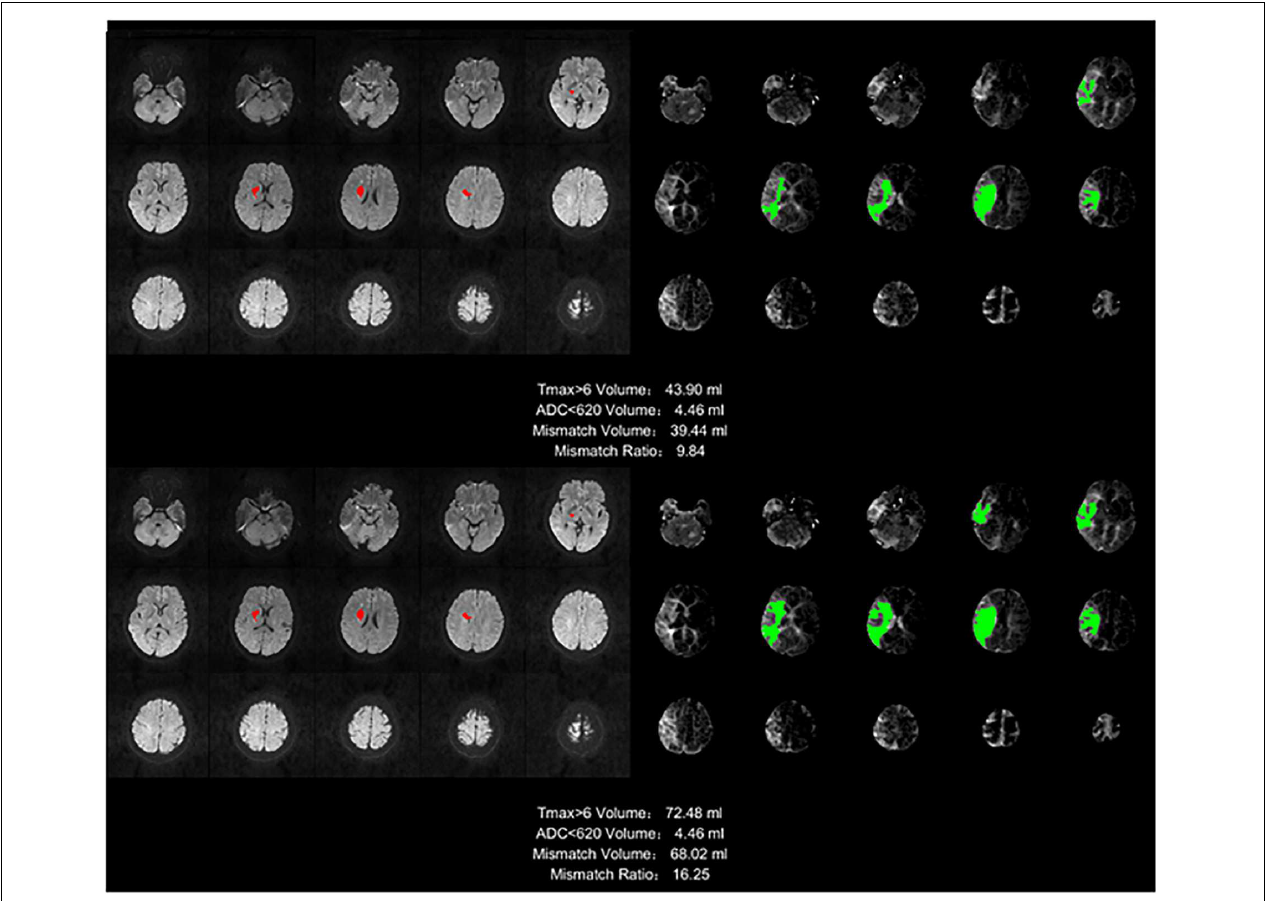
FIGURE 9 | Stroke analysis results of the ischemic region, the infarct core, the mismatch volume, and the mismatch ratio. The infarct core was marked in magenta while the ischemic region was marked in green.